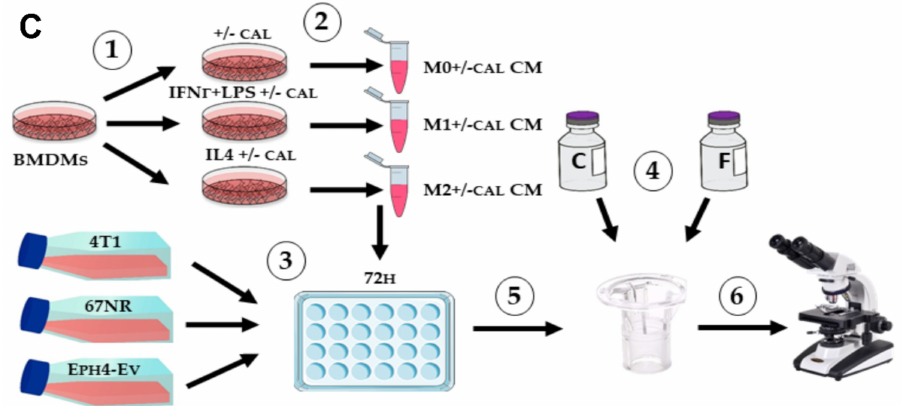
Figure8. E ff ectofBMDMsofindividualclasses, di ff erentiatedwithorwithoutcalcitriol, onthemigration properties of normal and cancer cells: migration through ( A ) collagen type IV and ( B ) fibronectin. Both M2 BMDMs di ff erentiated with and without calcitriol stimulated migration of 67NR cells through collagen IV, while M2 + cal BMDMs increased 4T1 migration by fibronectin. The migration assay was repeated 4 times for each cell line. Statistical analysis: Sidak’s or Dunn’s multiple comparisons